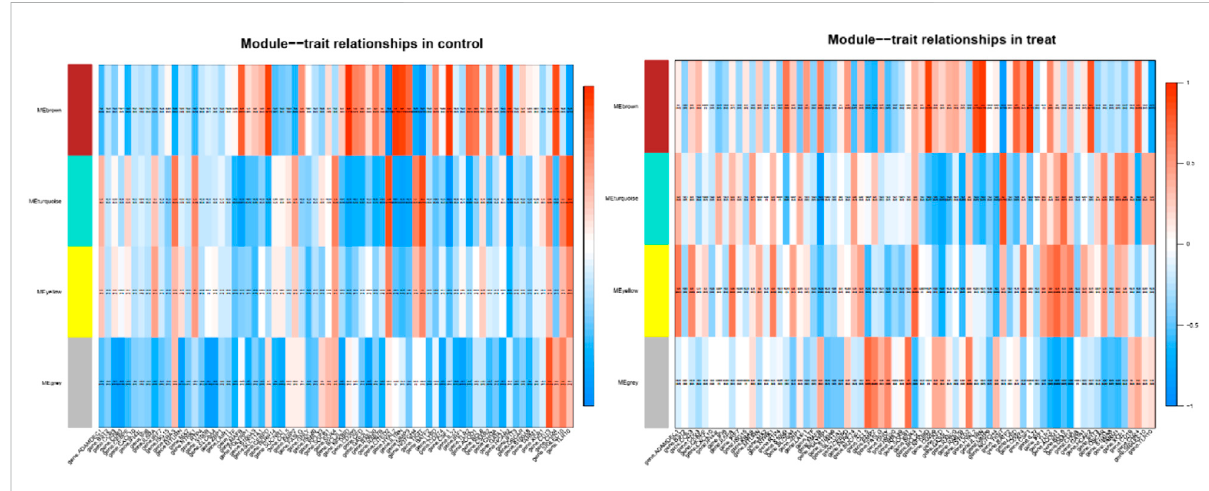
FIGURE 4 Module – differentially expressed immune-related genes association. Each row corresponds to a module, labeled with a color. Each column corresponds to differentially expressed immune-related genes. The color of each cell at the row-column intersection indicates the correlation coeffcient between the module and the tissue